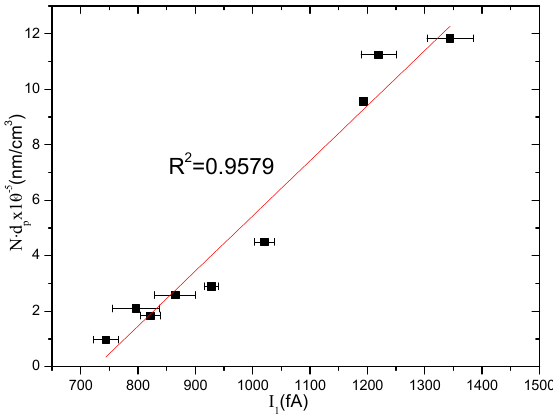
Figure 3. The relationship between N ¨ d p and I 1 for the measurement of monodisperse aerosols with Figure 3 . The relationship between (cid:1840) ∙ (cid:1856) (cid:3043) and (cid:1835) (cid:2869) for the measurement of monodisperse aerosols particle sizes in the range of 50–253 nm and number concentrations in the range of 300–2.5 ˆ 10 4 /cm 3 with particle sizes in the range of 50 – 253 nm and number concentrations in the range of 300–2.5 × 10 4 /cm 3 .